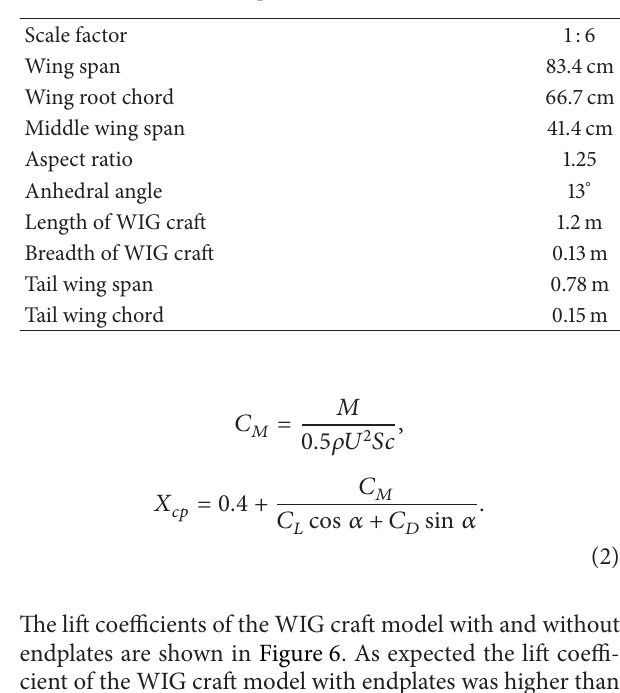
Table 1: Principle dimensions of WIG